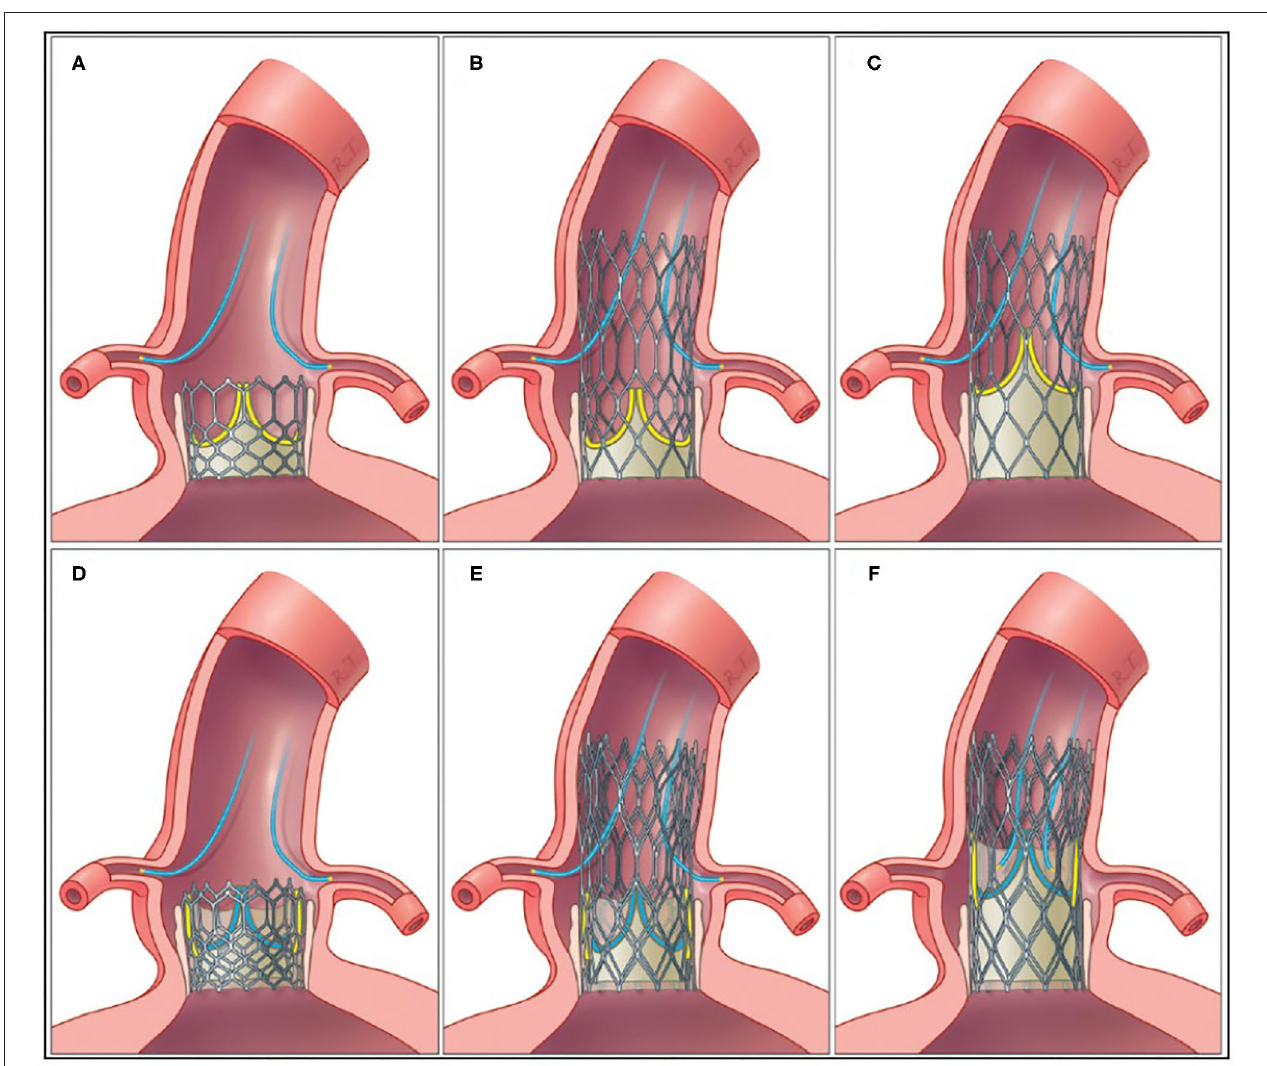
FIGURE 3 | Coronary access after first TAVI with low-frame and intra-annular leaflet position (A) , high-frame and intra-annular leaflet position (B) , and high-frame and supra-annular leaflet position (C) . After TAVI-in-TAVI, access to the coronary arteries may be possible in patients with low-frame and intra-annular leaflet position (D) and high-frame and intra-annular leaflet position (E) , whereas, access may be compromised in high-frame and supra-annular leaflet position (F) . Yellow leaflets = leaflets in the first implanted THV; blue leaflets = leaflets in the second implanted THV; yellow/gray shading = tissue